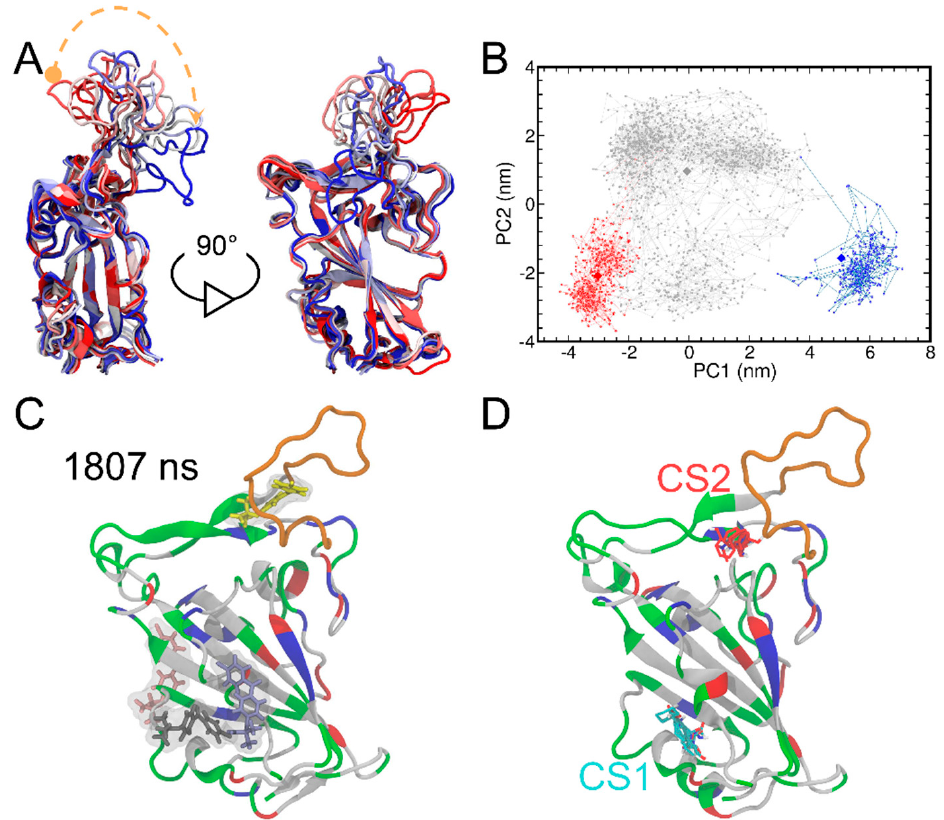
Figure 3. The superimposition of the RBD structures from MD simulations ( A ). The RBD protein is shown in the cartoon representation. The structures are colored on the basis of simulation time from red to white and blue. The curved dashed orange arrow highlights the time evolution of the loop fluctuations. The principal component analysis of the RBD structures from MD simulations is also shown ( B ). PCA results include graphs of PC1 vs. PC2 colored from red (0 − 388 ns) to gray (389 − 1769 ns) and blue (1770 − 2000 ns). The RBD structures at 70, 464 and 1996 ns (shown as diamonds) were determined as representative ones for the three clusters by using the centroid-based clustering method. The system snapshot at 1807 ns where FA I bind to the T470-F490 loop of RBD ( C ). The T470-F490 loop is shown in orange, while the rest of the protein is colored by the residue types (positively charged, negatively charged, polar, and nonpolar residues are shown in blue, red, green, and white, respectively). The FTMap analysis of the RBD protein structure at 1807 ns ( D ). The two major consensus sites (CS) (i.e., CS1 and CS2) indicated and small molecular probes in CS1 and CS2 are shown as cyan and red, respectively.